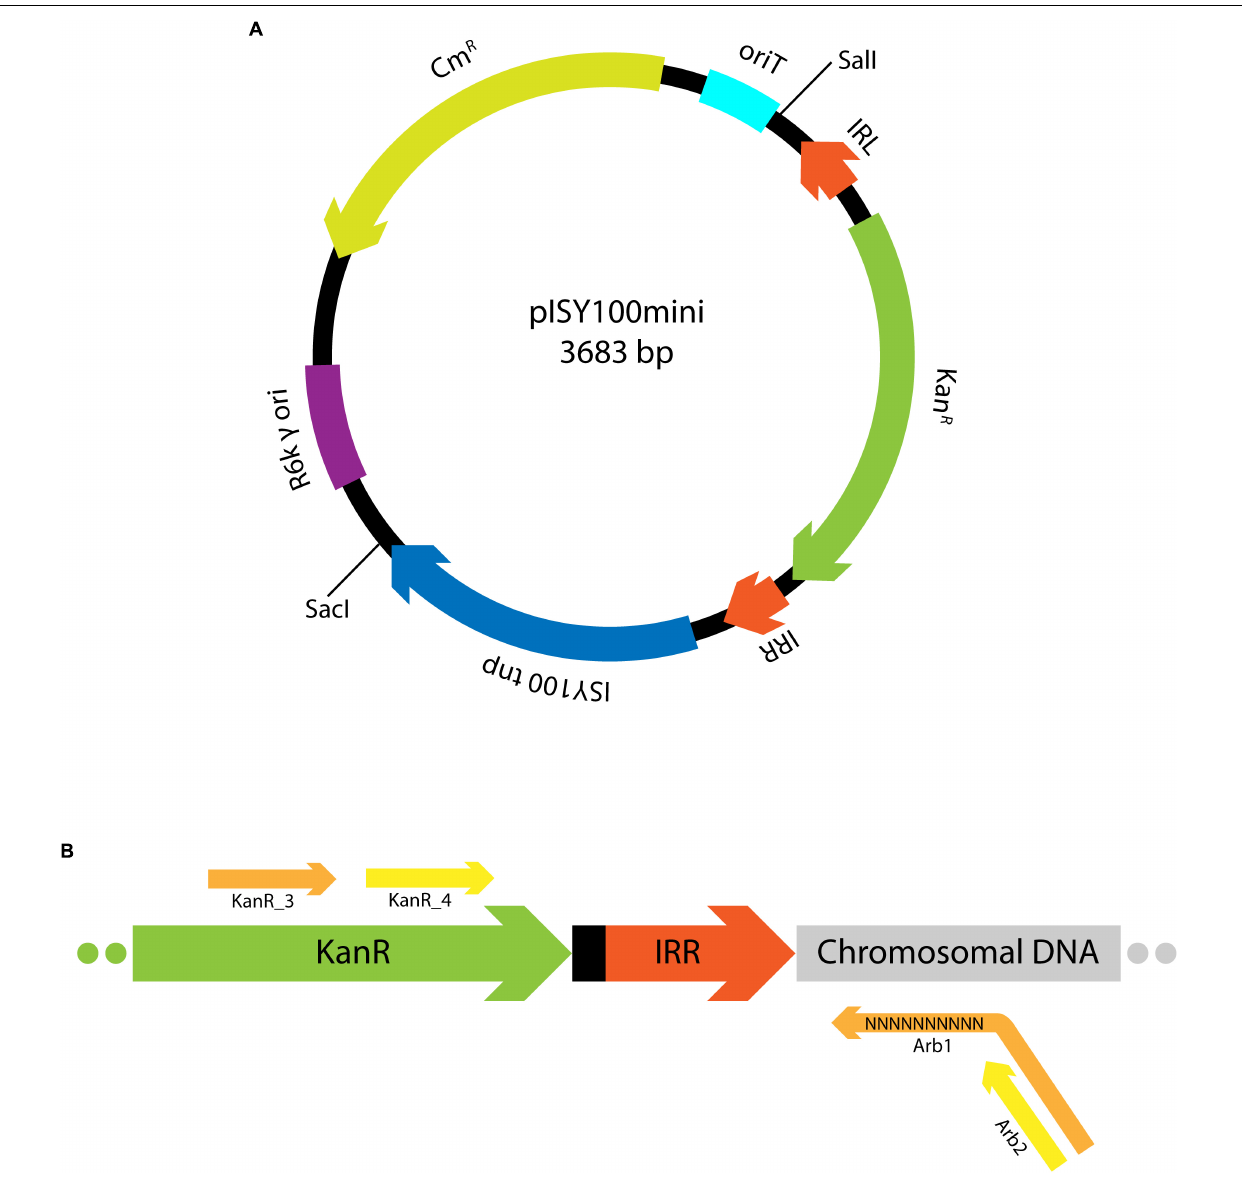
FIGURE 1 | Mini-ISY100 delivery system. (A) Map of the pISY100mini suicide vector, including the R6K γ origin of replication (purple), the origin of transfer oriT (light blue), the chloramphenicol resistance gene (yellow), the ISY100 transposase gene (blue), the ISY100 inverted repeat sequences IRL and IRR (dark orange) and the kanamycin resistance gene (green). (B) mini-ISY100 inserted in the host chromosome. The primers used in the arbitrary PCR to identify the mini-ISY100 transposon insertion site in the chromosomal DNA (light gray) are represented in orange (KanR_3 and Arb1, first amplification step) or yellow (KanR_4 and Arb2, second amplification